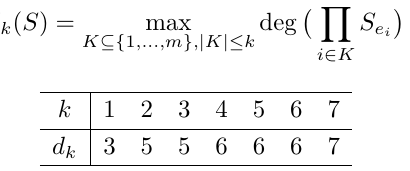
Table 8: Maximal degree of the product of k coordinates of MISTY1